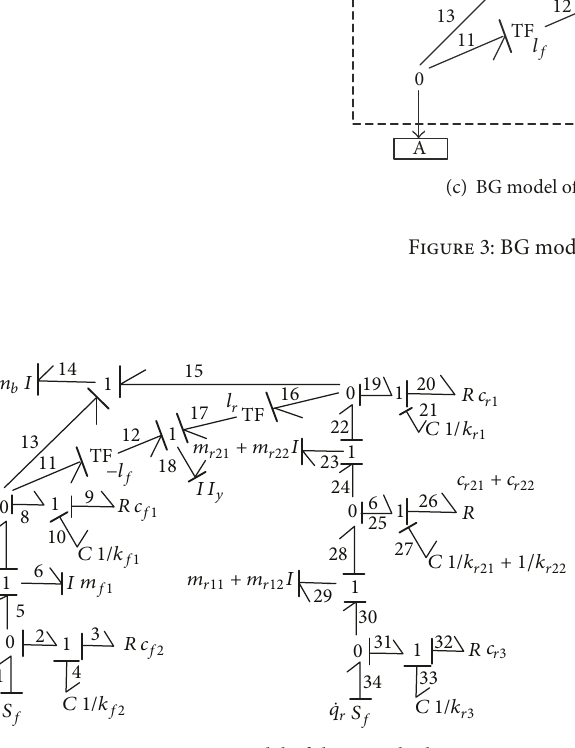
and angular momentum in a rotational motion. The symbols ̇𝑞 and ̇𝑝 represent the velocity and force in a translational motion and represent angular velocity and torque in a rotational motion. Each element in the BG model has a serial number corresponding to the different elements. Here, ̇𝑞 𝑖 ( 𝑖 = 𝑓, 𝑟 ) refers to the road surface roughness (RSR)